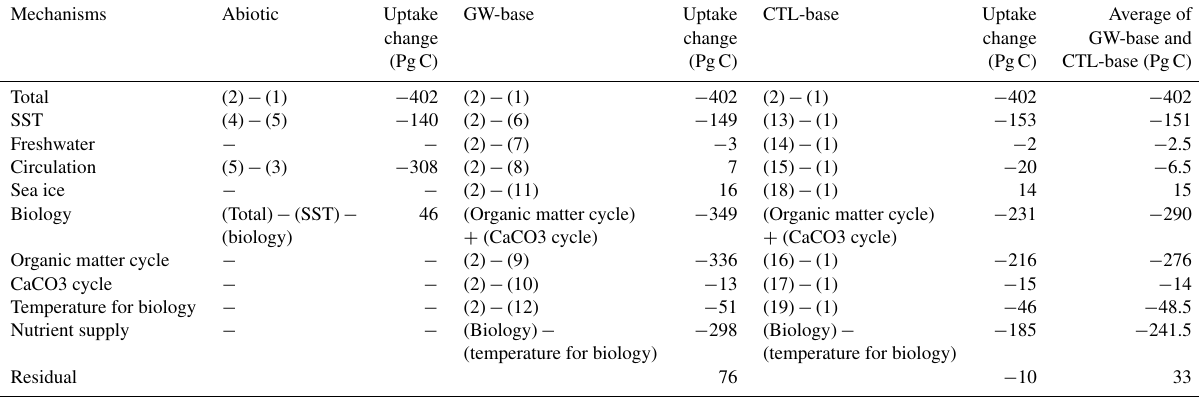
Table 2. The contributions of individual mechanisms to the reduction in the CO 2 uptake due to global warming in the first 500 years. Mechanisms